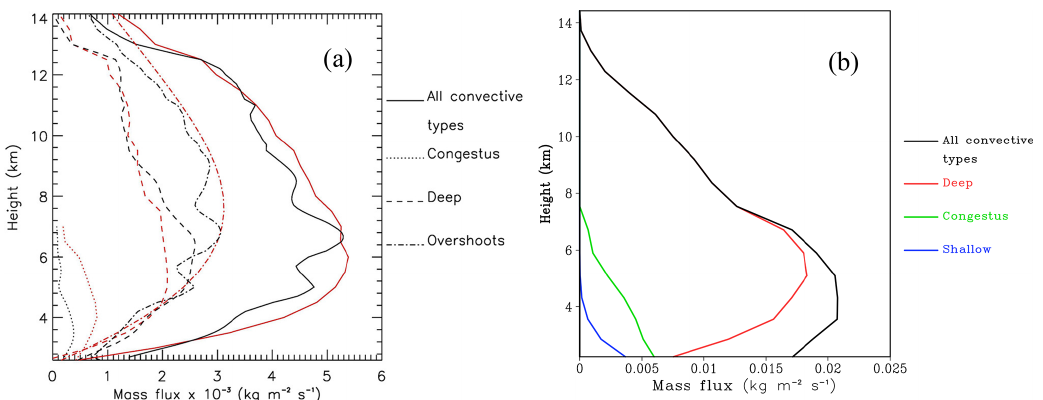
Figure 4. (a) On the left is the two-season mean mass flux associated with all cumulus clouds (solid curves), congestus (dotted), deep (dashed), and overshooting convection (dotted–dashed) using wind-profiler (black) and CPOL-based (red) measurements taken at the profiler site (From Kumar et al., 2016, © American Meteorological Society; used with permission). (b) On the right are the TWP-ICE mean mass flux (kgm 2 s − 1 ) profiles from all cumulus clouds (in black), shallow (in blue), congestus (in green), and deep convection (in red) with GF SCM simulation.